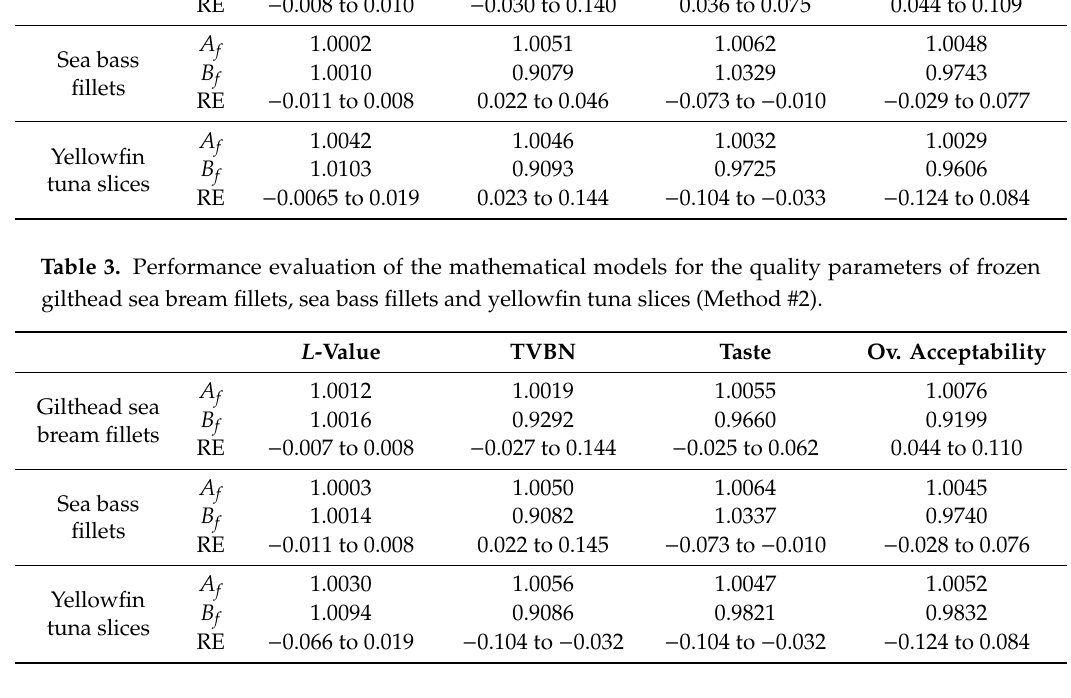
Table 3. Performance evaluation of the mathematical models for the quality parameters of